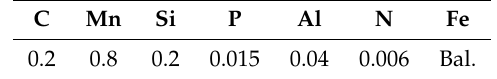
Table 1. Composition of the steel used in this study (wt